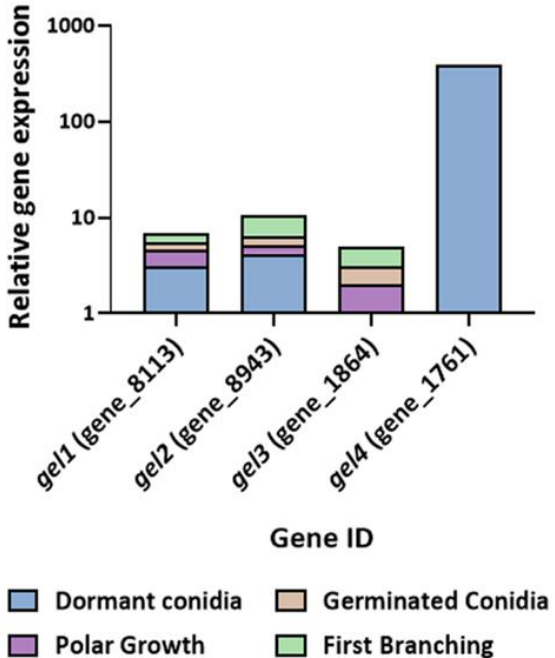
Figure 7. Log relative gene-expression levels of Trichoderma asperelloides glucan elongases across four stages of conidial germination. Gene expression was determined by RT-PCR. Values shown are based on three biological repeats, with whiskers signifying one standard error. Gene expression was normalized to tef1 . The threshold cycle (2 − ∆∆ CT ) method was used to determine fold changes in